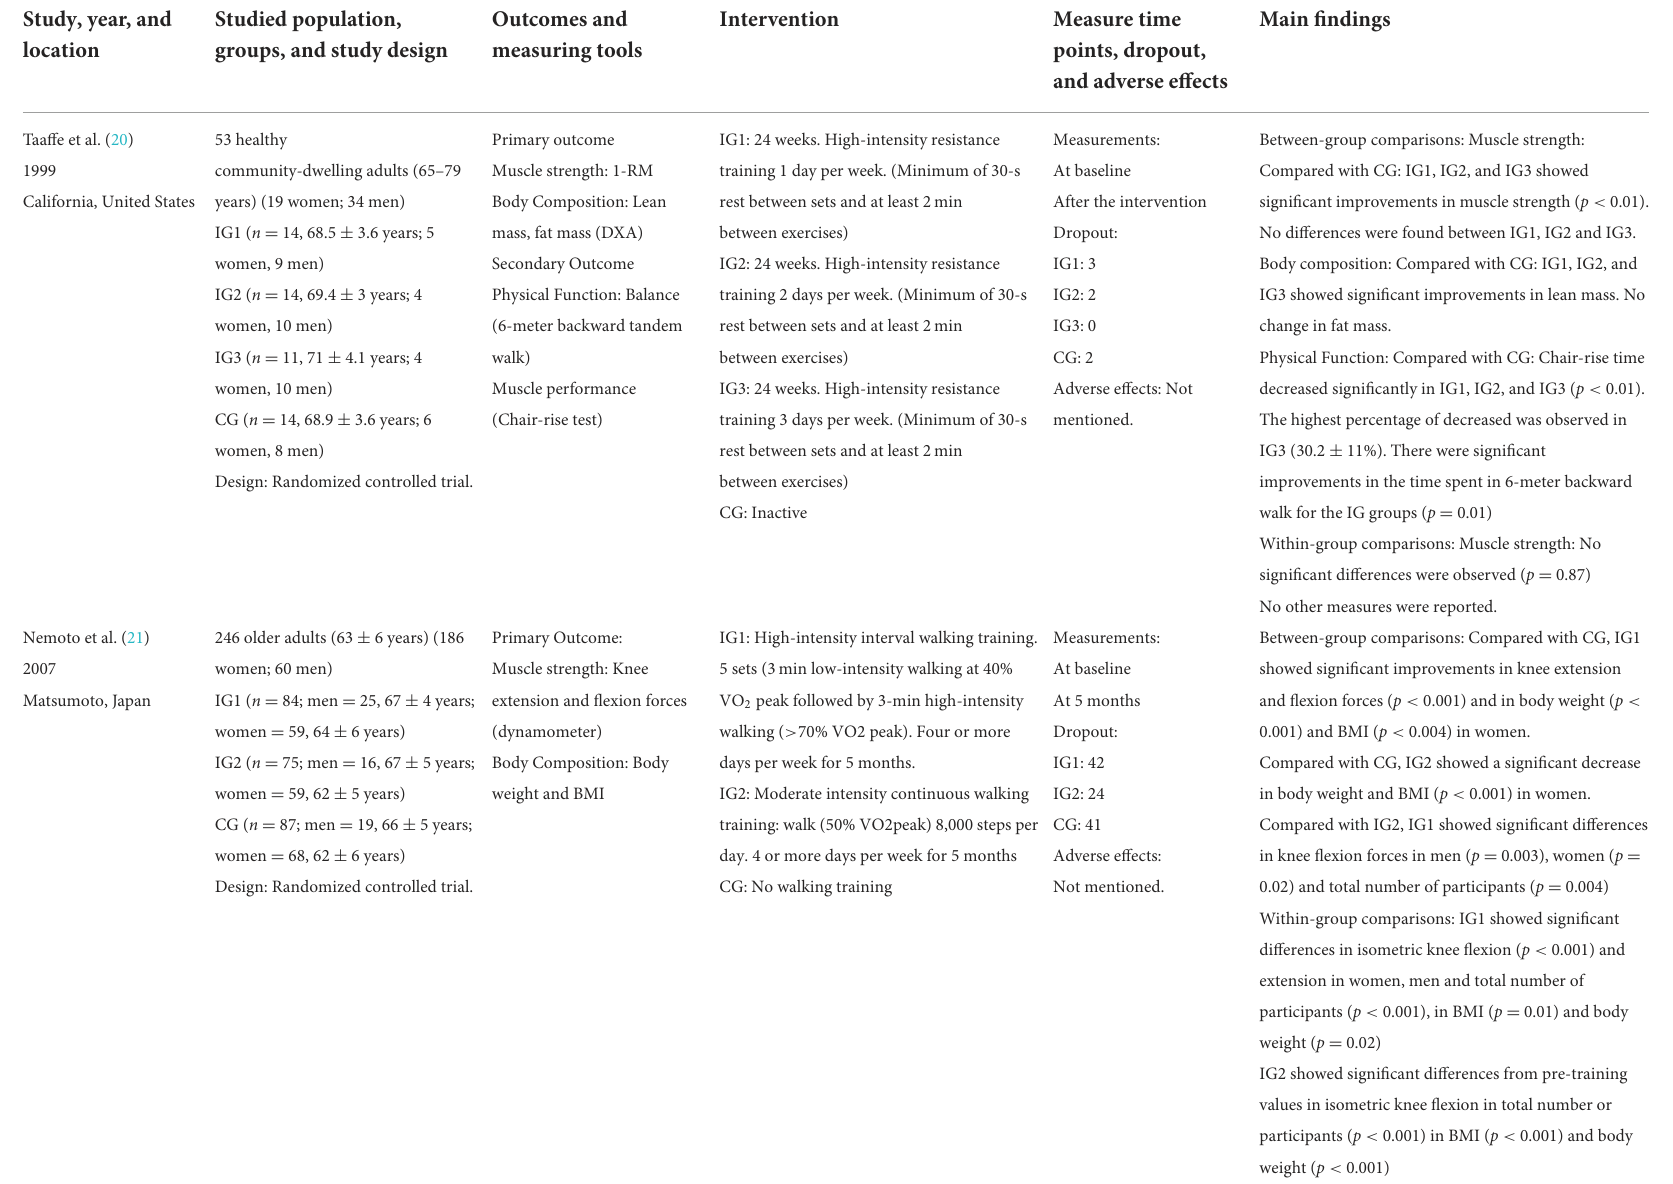
TABLE 2 Summary of included studies ( n =